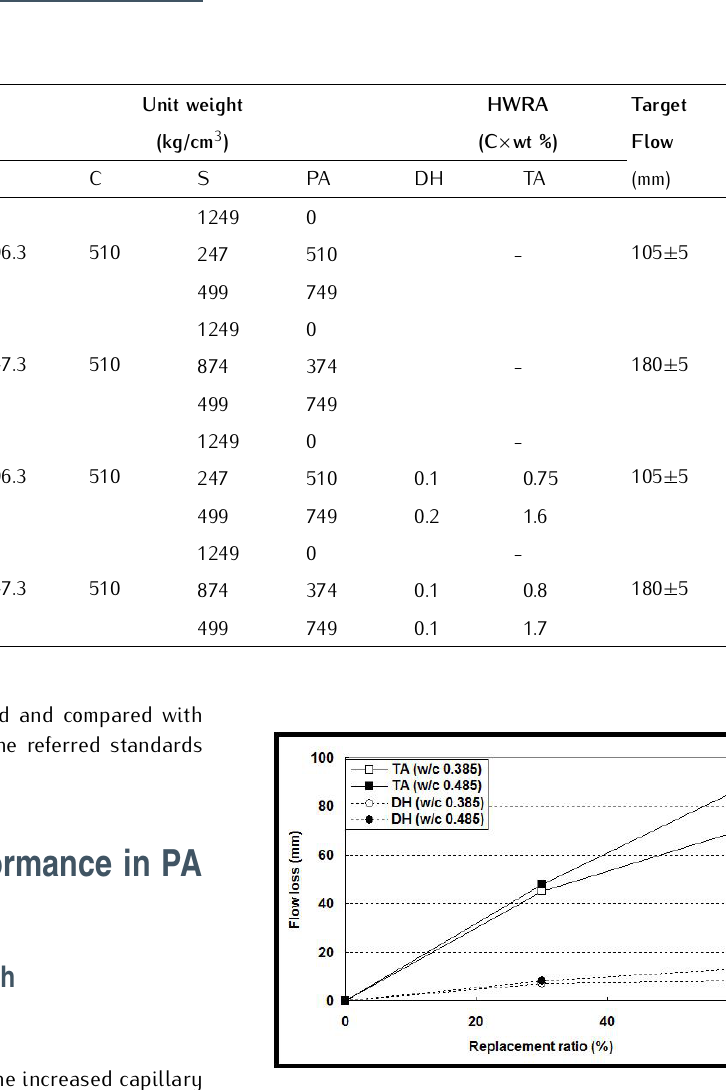
loss of flow with replacement ratio. PA mortar from DH has higher absorption ratio of 6.32% and this is fully saturated in mixing stage. Another influencing parameter to flow seems to be the shape of PA. PA from DH has clean and smooth surface compared with that from DH as shown in Figure 3. The ball bearing effect like fly ash [23] can help to resist flow loss with